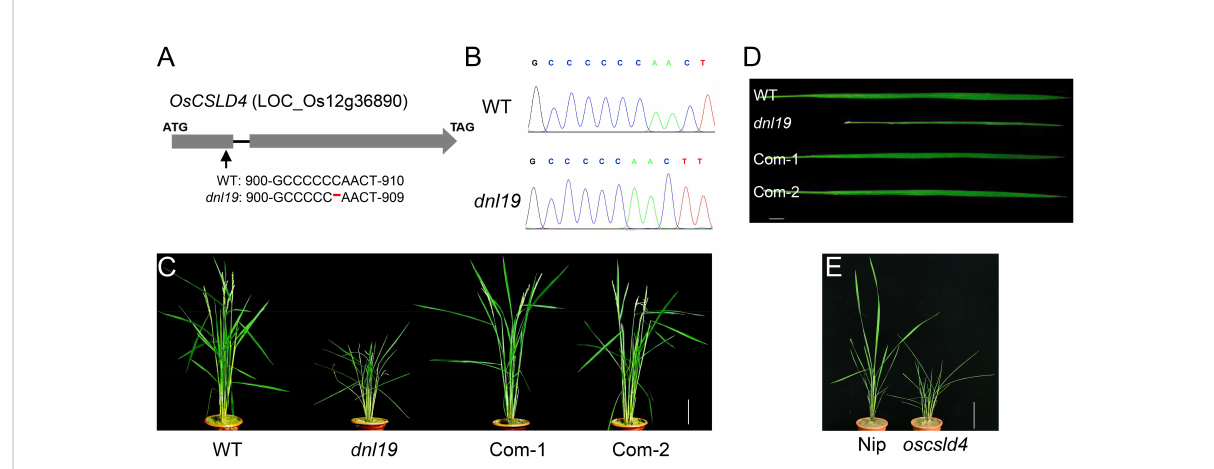
FIGURE 3 OsCSLD4 is the causal gene of dnl19 mutant. (A) Schematic diagram (not in scale) illustrates the InDel site in OsCSLD4 . The arrow indicates the position of the dnl19 mutation, and the red dash indicates a C base deletion. (B) Sequencing results of the OsCSLD4 in wild type and dnl19 mutant. (C) Leaf morphology of the wild plant, dnl19 and functionally complemented plants (Com-1, Com-2). Bar = 1 cm. (D) Gross morphology of WT, dnl19 , Com-1 and Com-2 at the maturing stage. Bar = 10 cm. (E) Gross morphology of Nipponbare (Nip) and oscsld4 at the tillering stage. Bar = 10